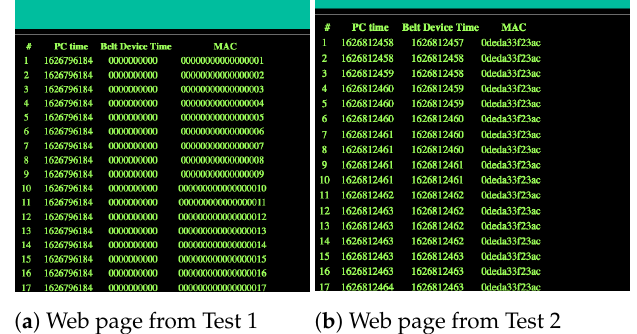
Figure A2. Screenshot of Web pages during the